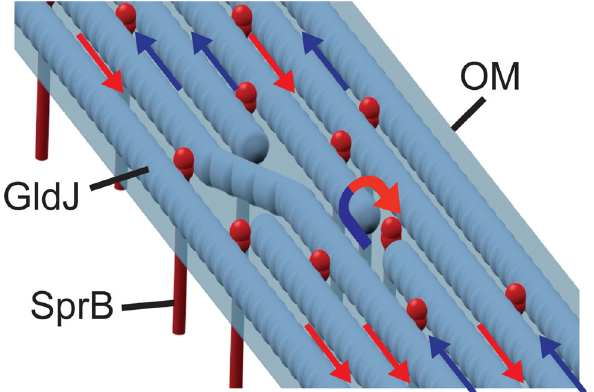
Fig. 6 Models for the multirail structure for gliding machinery. Multirail structure on the periplasmic face of the outer membrane (OM). The allows indicate the direction of SprB movement. The blue-to-red arrow indicates lane-switching by SprB resulting in a